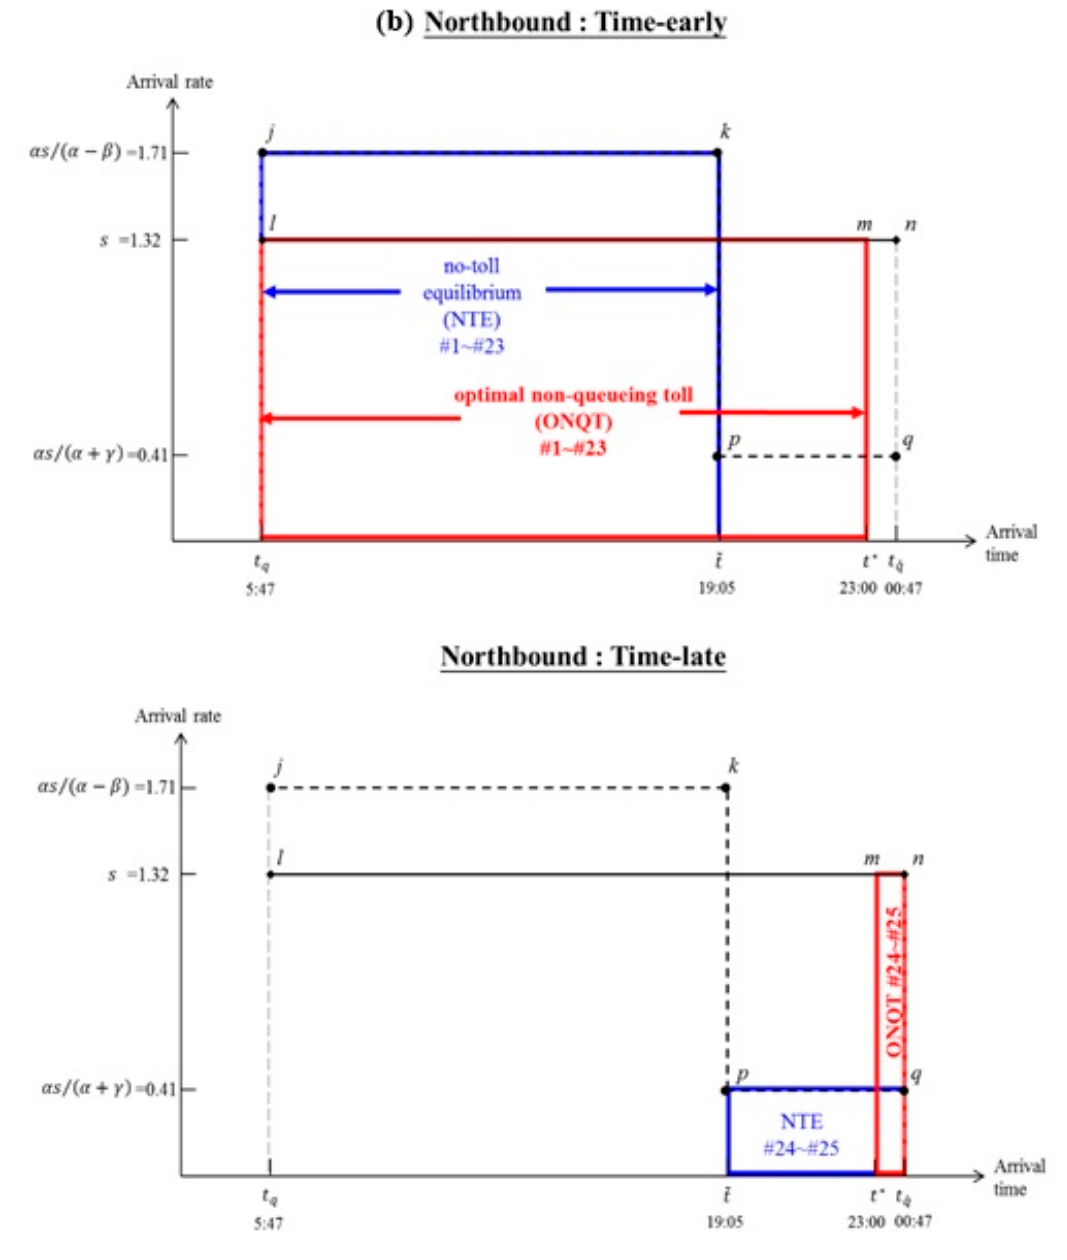
Figure 2. ( a ) Numerical example of ships’ arrival time adjustments for the southbound ships from the no-toll to the tolled case. ( b ) Numerical example of ships’ arrival time adjustments for the northbound ships from the no-toll to the tolled case.